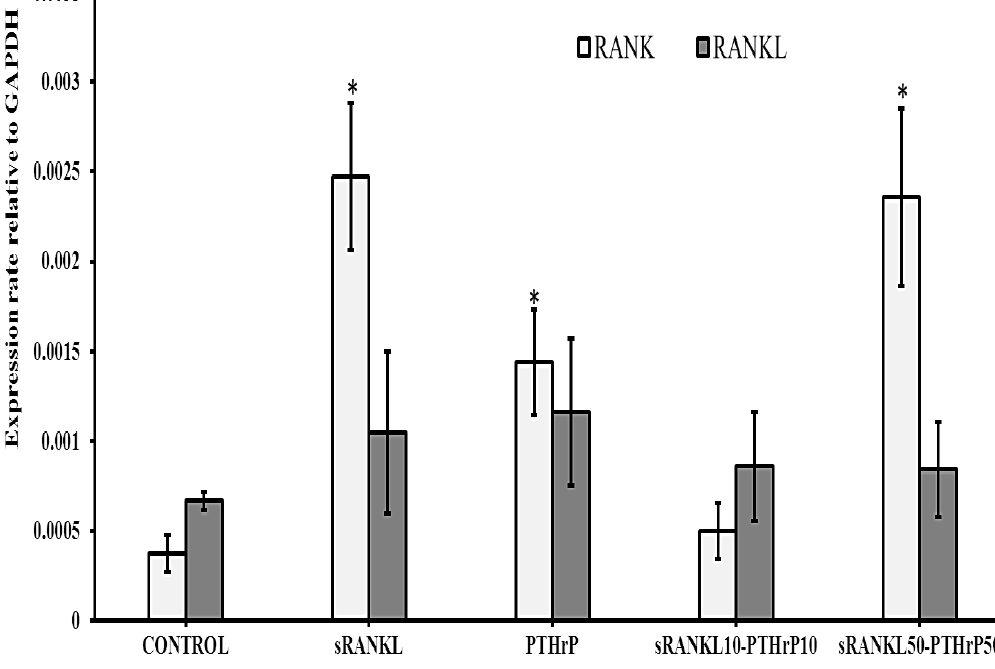
Figure 4. RANK and RANKL mRNA expression of MSCs treated with sRANKL and PTHrP, * p < 0.05 vs. control.